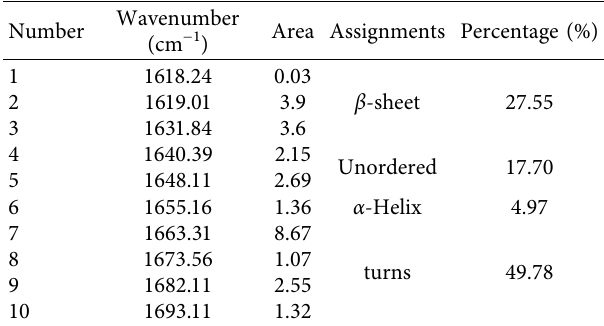
Table 4: The assignments of curve-fitting spectra and secondary structural ratio for